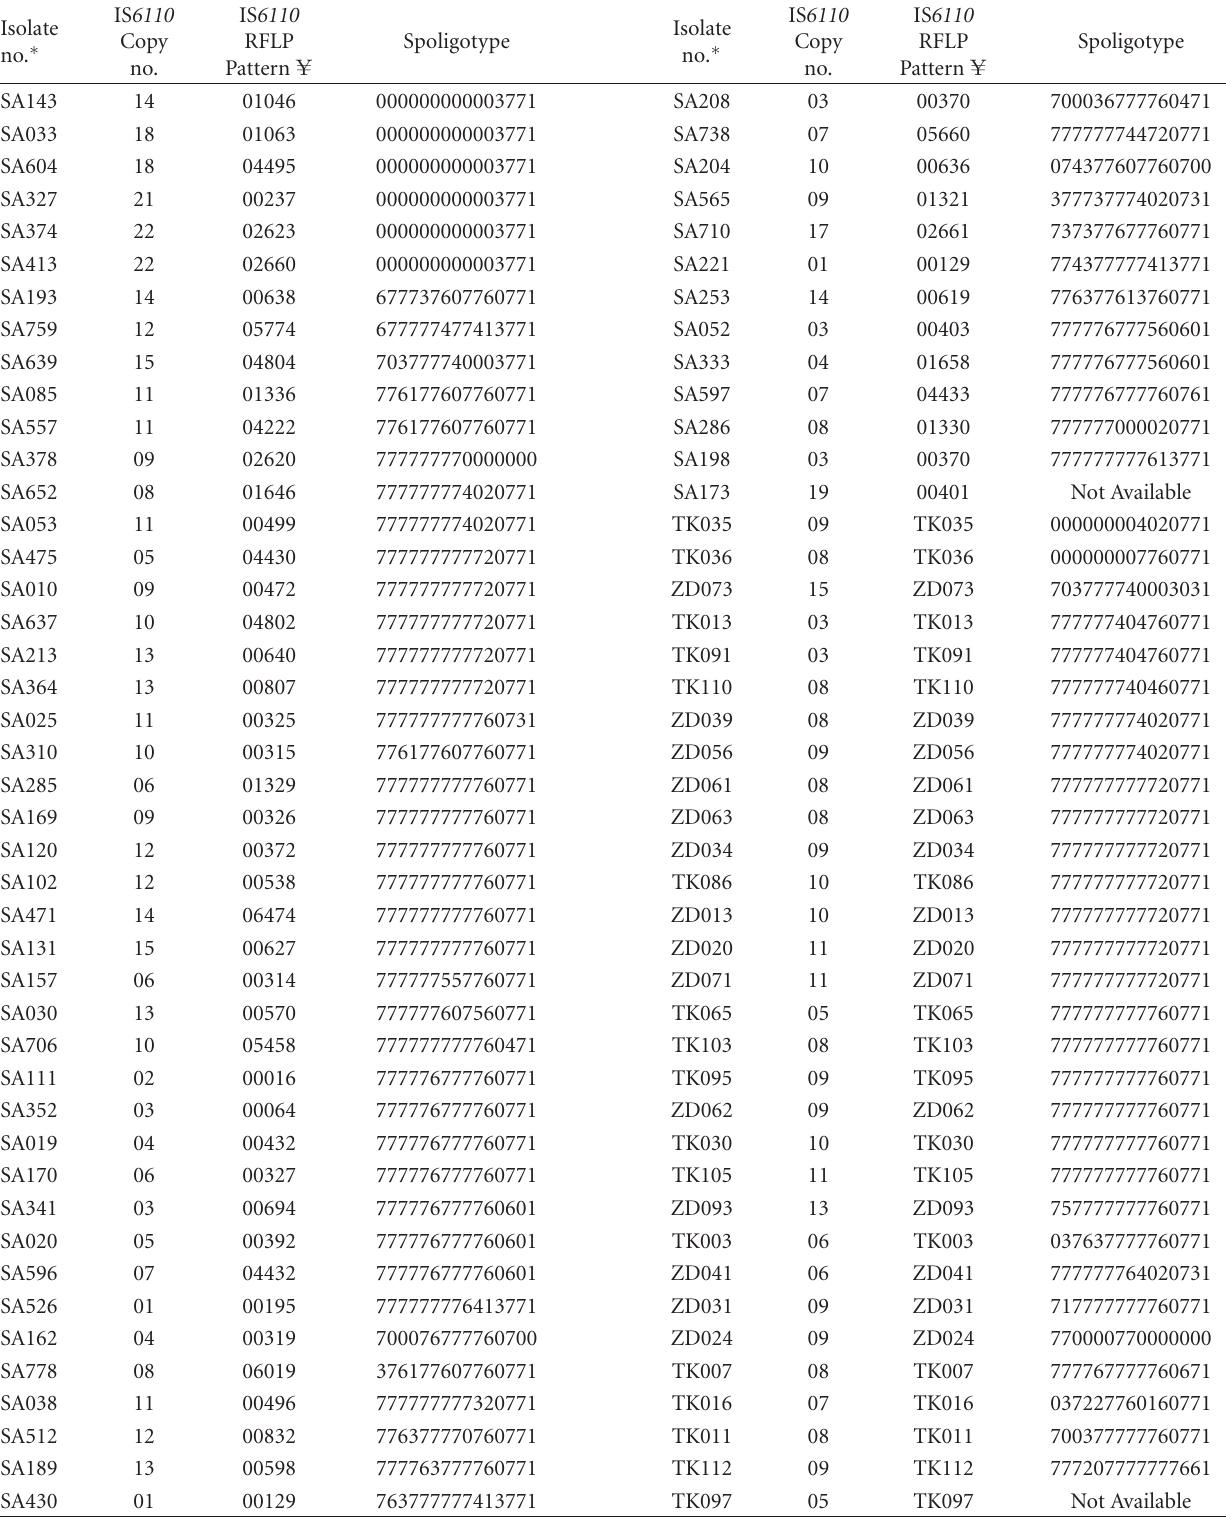
Table 1: Genotyping data of the 88 study isolates of M. tuberculosis that were originated from Arkansas, USA, and Turkey.